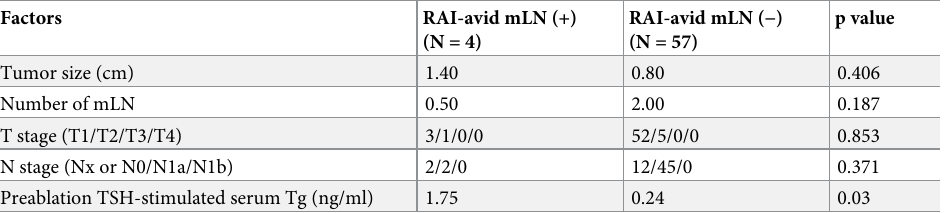
Table 4. Comparison of clinicopathological parameters between patients with and without RAI-avid mLN in the low-risk group. Factors RAI-avid mLN (+) RAI-avid mLN (−) p value (N = 4) (N = 57) Tumor size (cm) 1.40 0.80 0.406 Number of mLN 0.50 2.00 0.187 T stage (T1/T2/T3/T4) 3/1/0/0 52/5/0/0 0.853 N stage (Nx or N0/N1a/N1b) 2/2/0 12/45/0 0.371 Preablation TSH-stimulated serum Tg (ng/ml) 1.75 0.24 0.03 Data are presented as number or median. TSH: thyroid-stimulating hormone; Tg: thyroglobulin; mLN: